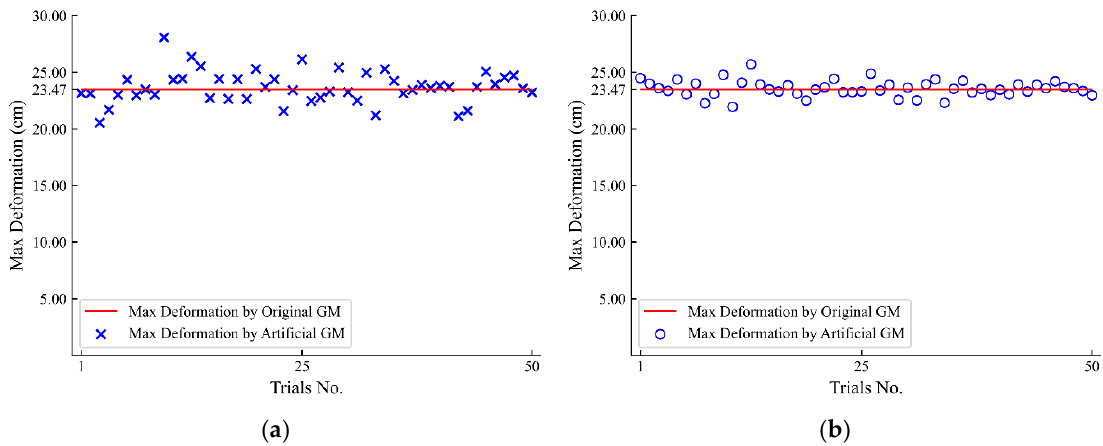
Figure 10. Distribution of max response deformations by artificial GMs synthesized using ( a ) CWT and ( b ) DWT.